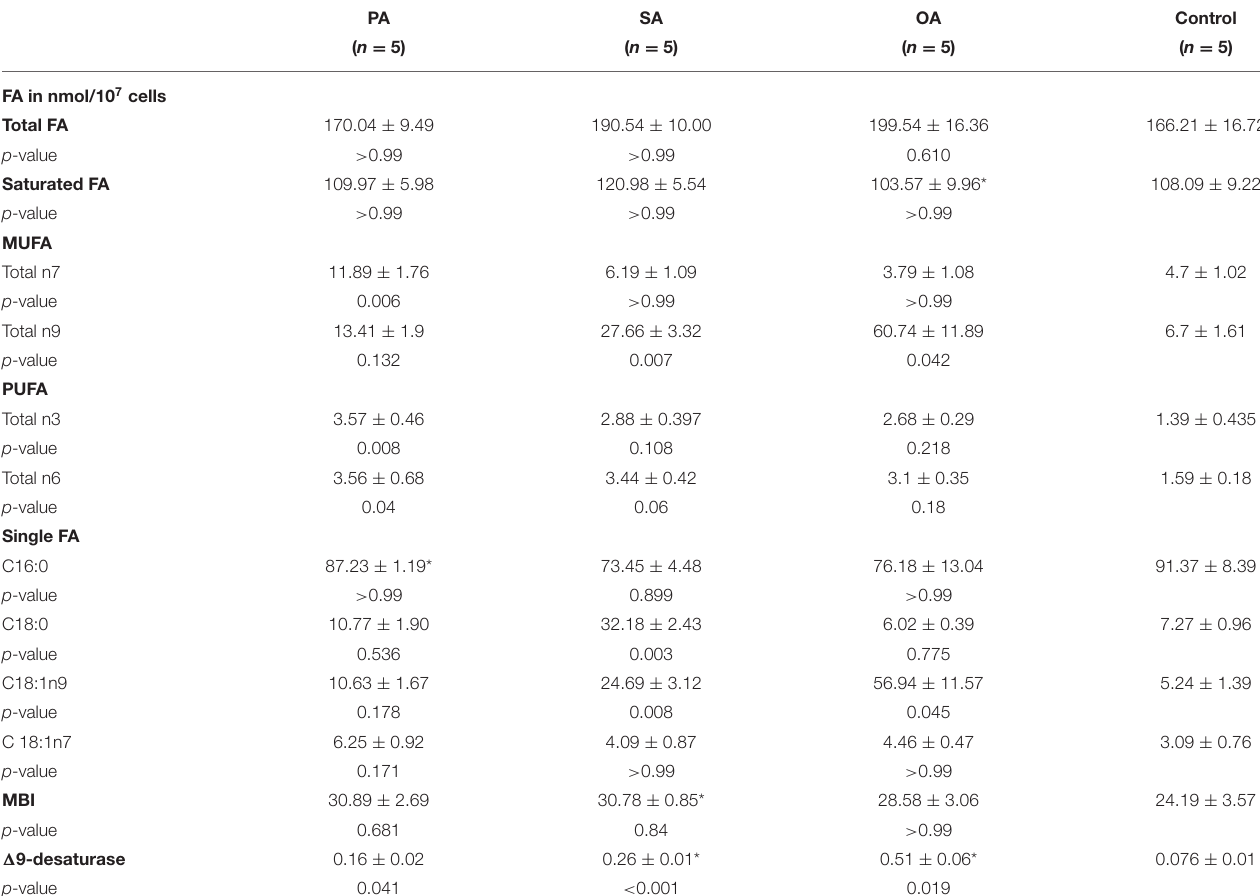
TABLE 5 | Fatty acid pattern of NEFA.